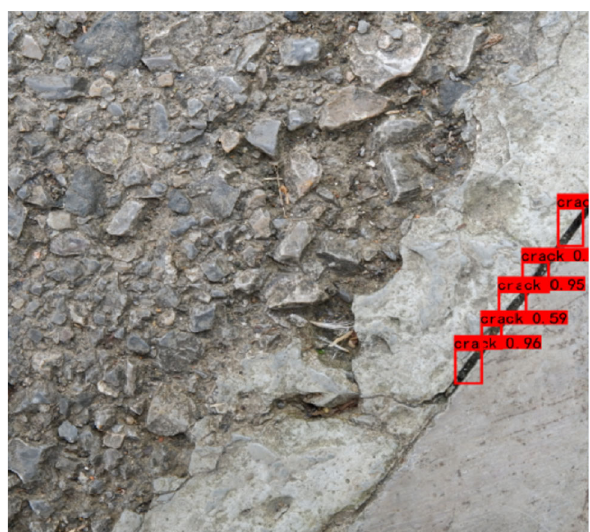
Fig. 16 Result of complex sample image